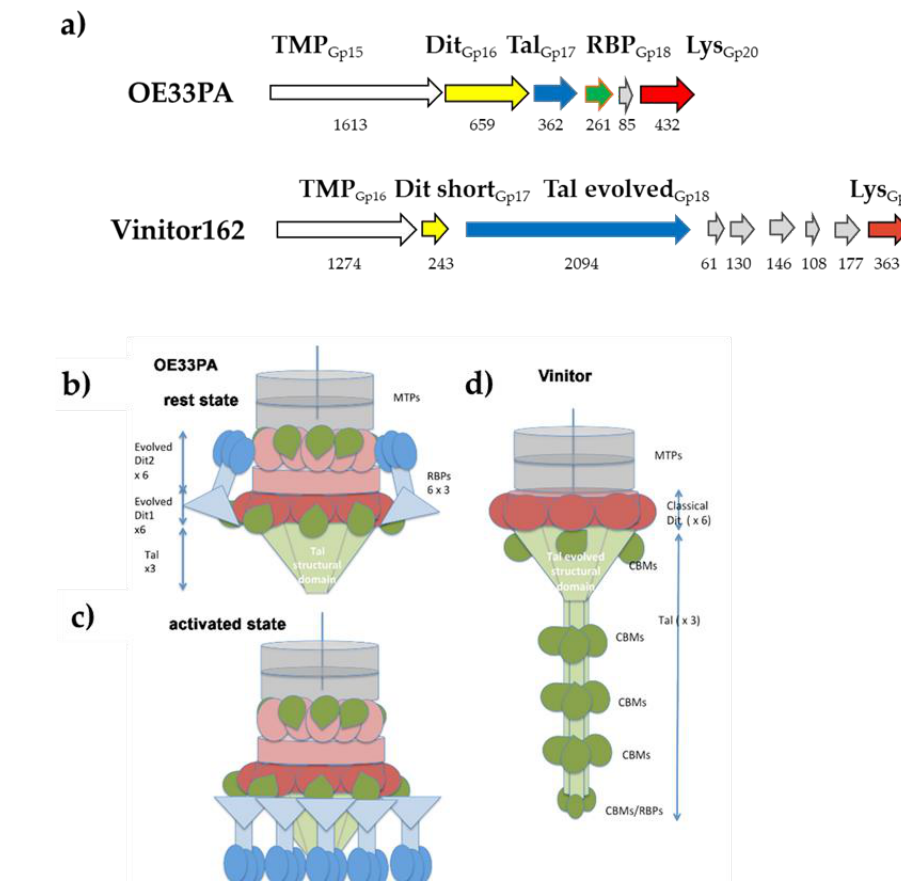
Figure 4. Topology models of phages OE33PA and Vinitor162. ( a ) comparison of the phage genomes between the tmp and endolysin genes (the sizes of deduced proteins in amino acids are given); ( b , c ) topology models of the OE33PA baseplate in resting and activated states (based on phage p2 baseplate structures [43,44]. Phages with an activation mechanism for host binding possess two distal tail (Dit) hexamers, (Dit1 in dark pink and Dit2 in light pink). Each evolved Dit monomer harbors one (or two) carbohydrate-binding modules (CBMs) (one CBM is shown here). The trimeric Tal (light green) is reduced to a mere structural domain. The trimeric receptor-binding protein (RBP) assembles shoulder and neck domains (light blue) followed by the receptor-binding domain (dark blue). The RBPs rotate by ~180 ◦ during the activation process; ( d ) Topology model of Vinitor. The classical Dit hexamer is colored dark pink. The trimeric Tal is composed for each monomer (from N- to C-terminus) of a CBM domain (dark green), a structural domain (light green) and an extended tail (light green) carrying three CBMs (dark green) and terminated by a fifth CBM / RBP domain (dark green). MTP, Major Tail Protein. For OE33PA, HHpred [36] identified that Gp16 is an evolved distal tail (Dit) protein (the host-binding device hub docking structure), which contains carbohydrate-binding module (CBM) insertions as compared with classical Dit, related to that of Lactococcus lactis phage p2 (PDB ID 2WZP, Figure S3). The size of OE33PA Dit (659 amino acid residues) suggests that there